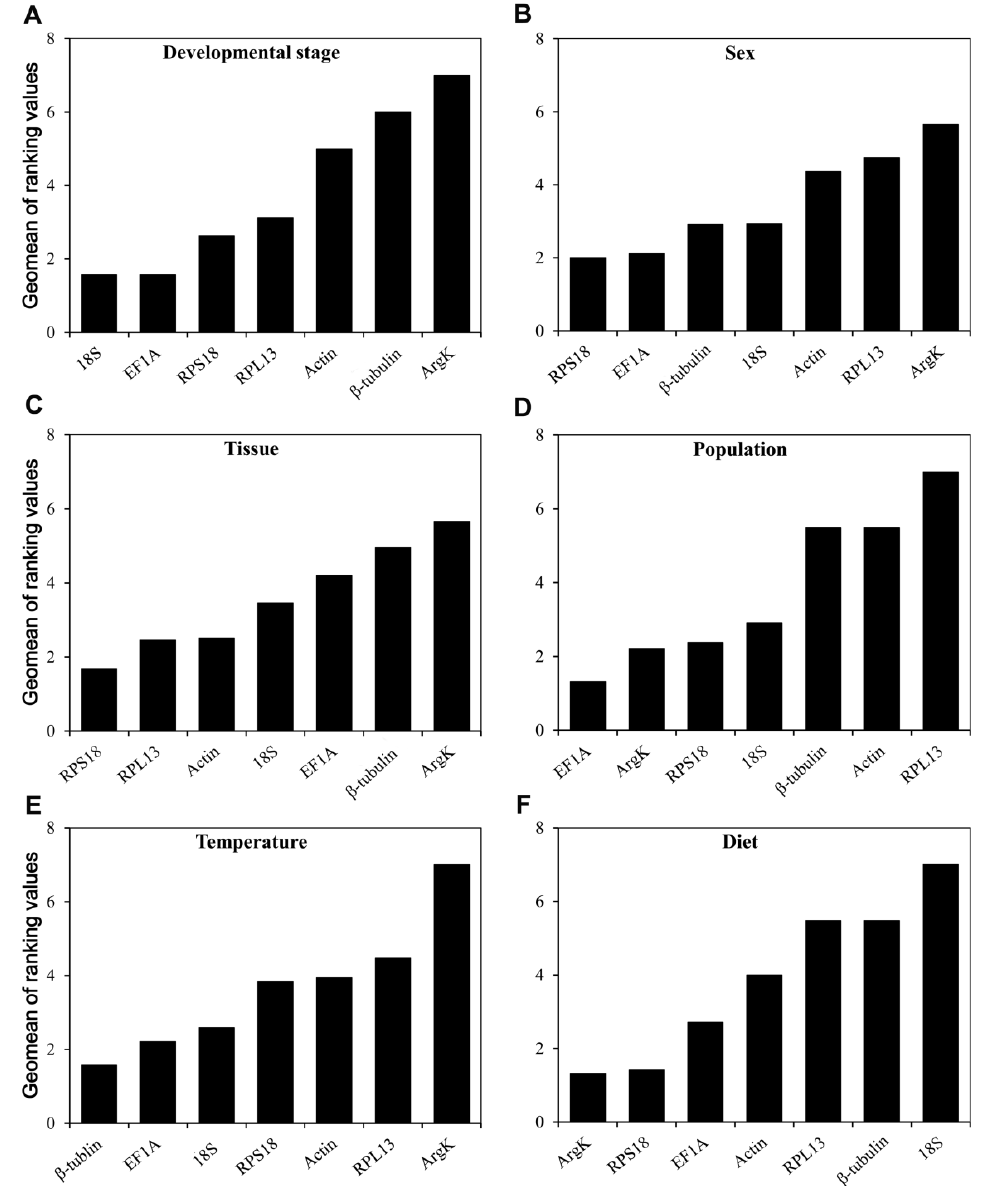
Figure 6. Stability of the seven candidate reference gene expressions in T. radiata under different treatment conditions analyzed using RefFinder . A lower Geomean value indicates a more stable expression based on RefFinder . ( A ) Developmental stage, ( B ) sex, ( C ) tissue, ( D ) population, ( E ) temperature, and ( F ) diet.